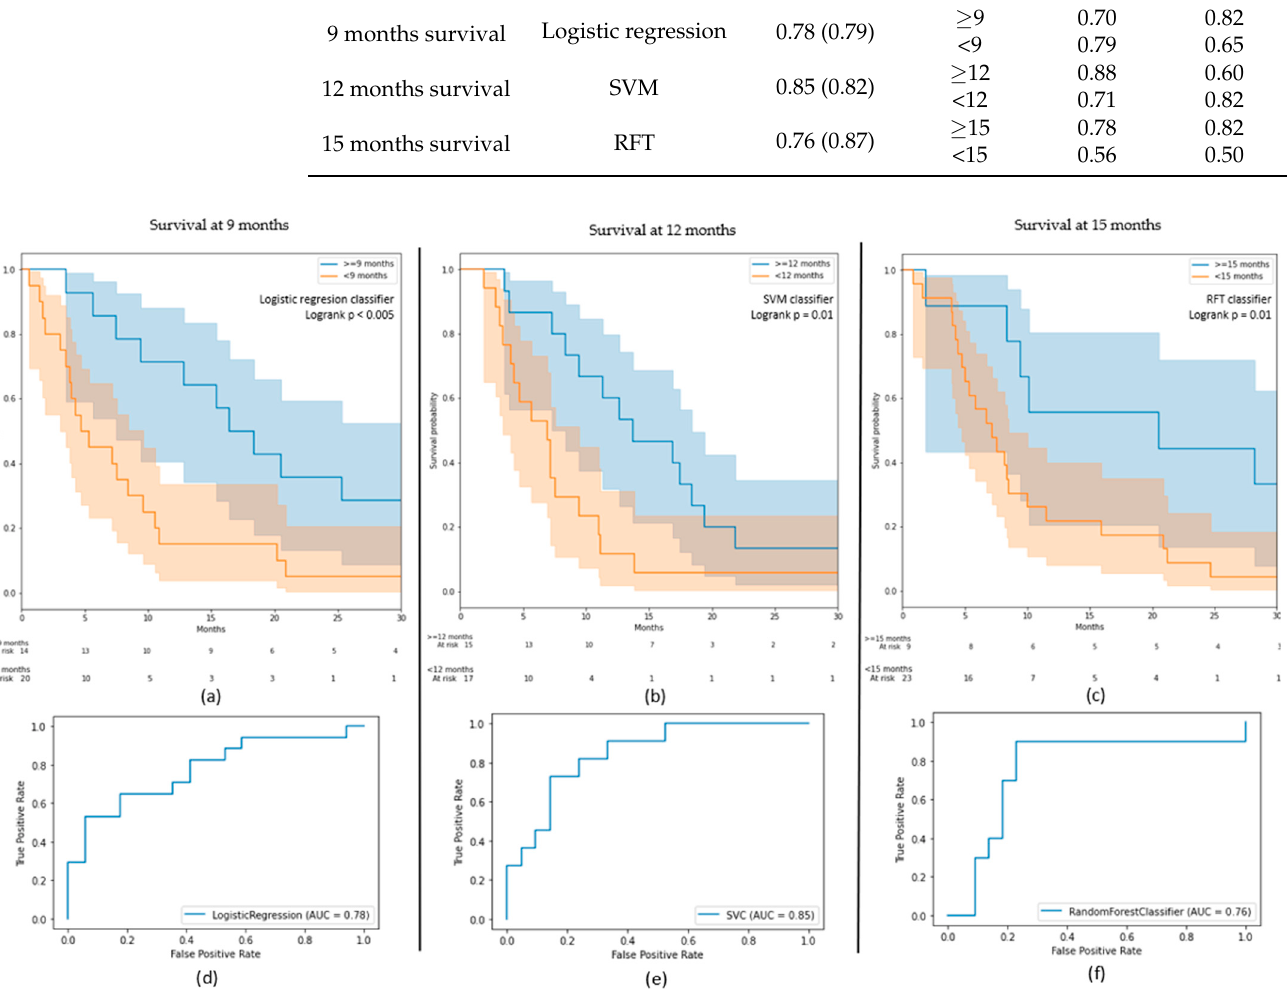
AUC on Test Classes Precision Recall (on Train)